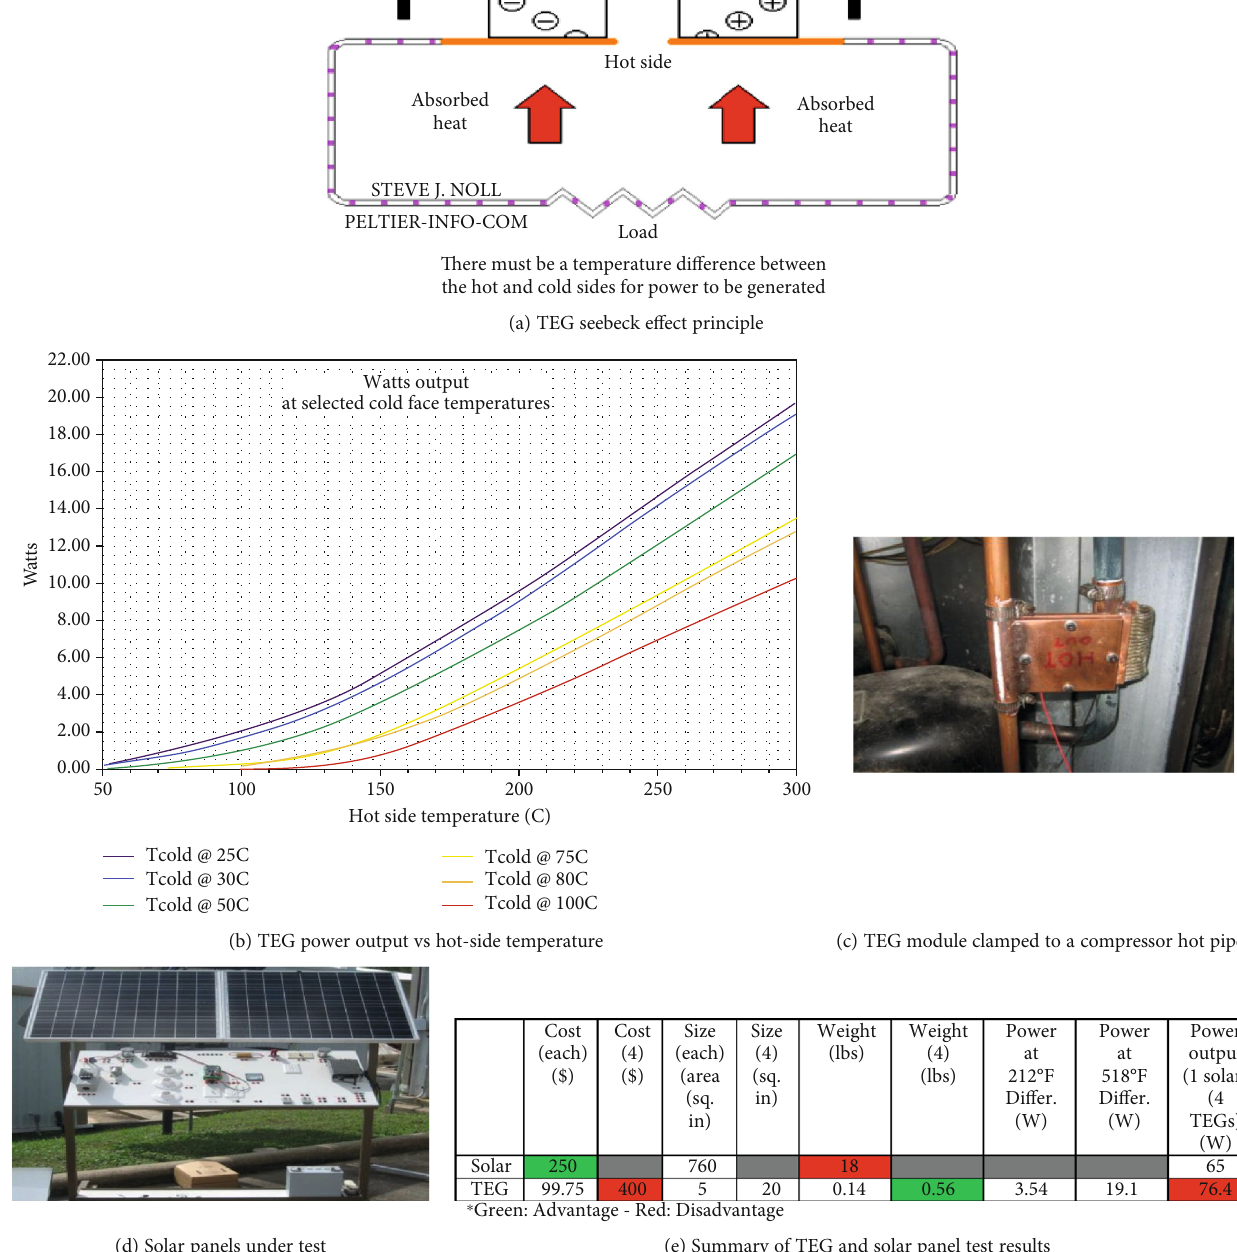
Figure 15: TEG versus solar energy generations comparison (adapted from TEG concept. Figure 15(b) depicts the output power based on TEG temperature di ff erences on both sides. The tested TEG hot side temperature ranged from 50 to 300 ° C and cold